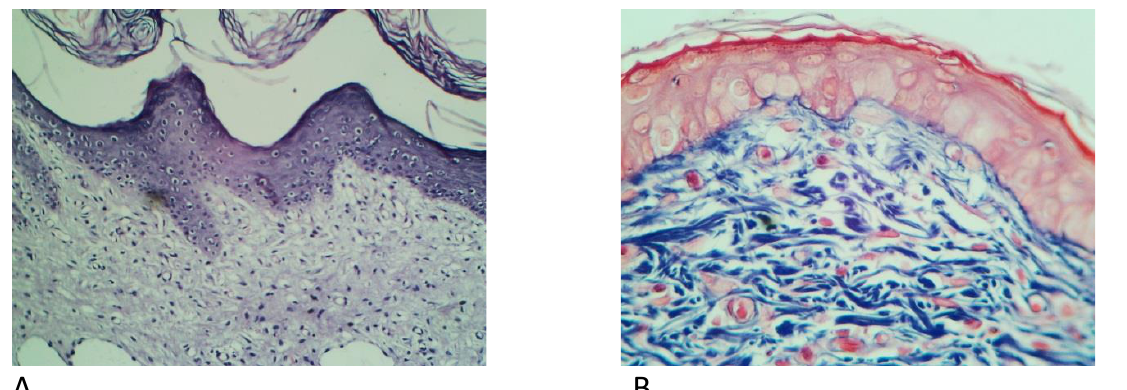
Figure 8: View of Myrrh oil group at day 14 showed, A: keratin layer, HF, complete formation of epithelium, H&E, X10.B: large area occupied by remodeling collagen fiber (Col) and invaded by blood vessel, MT,